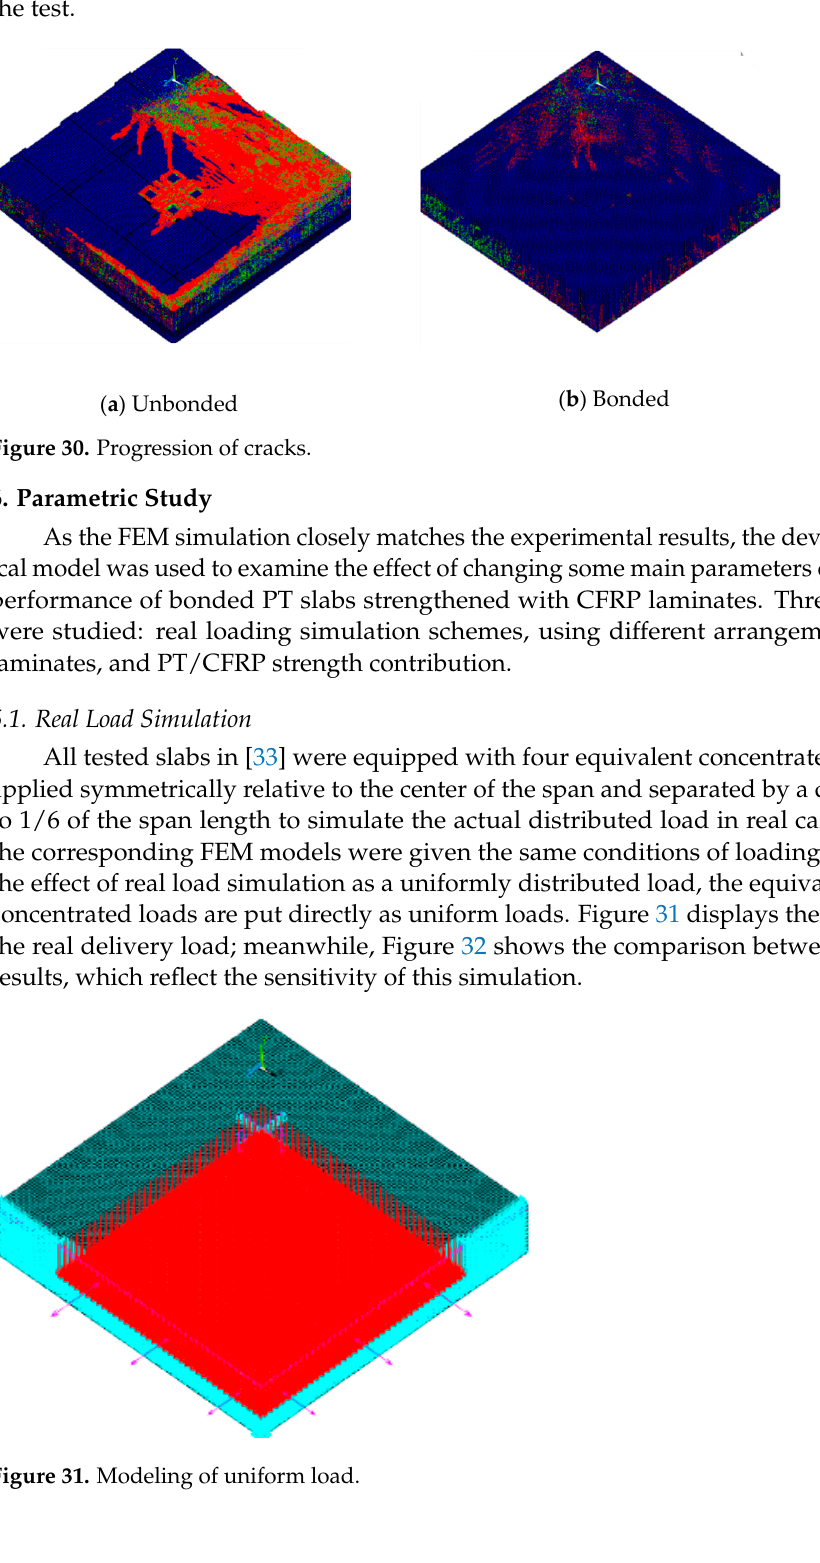
400 Figure 32. FEM simulation comparison between equivalent test loads and real uniformly distributed load for slab BS1. 6.2. Different Arrangements of CFRP Laminates To investigate the effect of the optimum CFRP laminate position selection, two dif- ferent schemes of distribution were investigated. The first scheme of laminate attachment location was selected to be adjacent to columns only (column laminate), and the other was at the middle span only (field laminate), as shown in Figures 33 and 34. From the results, it was observed that the column laminate had a significant impact, such as delaying the first crack load and producing less deflection, as can be seen from Figures 35 and 36. Figure 33. Modeling of CFRP laminate adjacent to columns (column laminate). 0 100200300